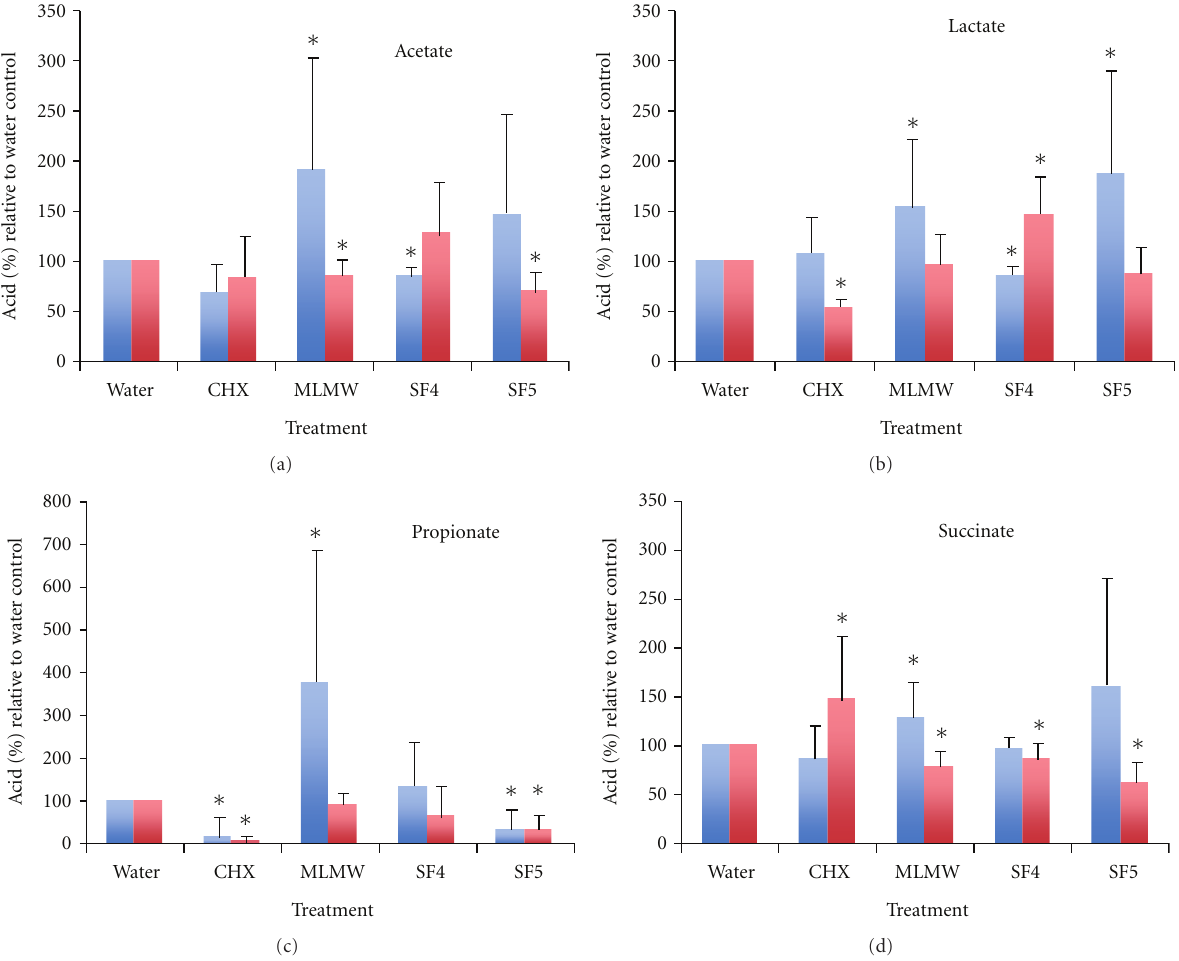
Figure 4: Amount of (a) acetate, (b) lactate, (c) propionate, and (d) succinate in 8-day microcosms at a resting state (blue bars) and at a fermenting state after 30 min incubation with 1% glucose (red bars) in the treatment group samples (CHX—chlorhexidine digluconate; MLMW—mushroom low molecular weight extract; SF4—subfraction nr 4 of MLMW extract; SF5—subfraction nr 5 of MLMW extract) relative to the samples exposed to water (negative control). Treatments were performed twice daily for 10min (Figure 1). ∗ One sample t -test, treatment versus 100% (water control), significantly di ff erent at P < 0 .